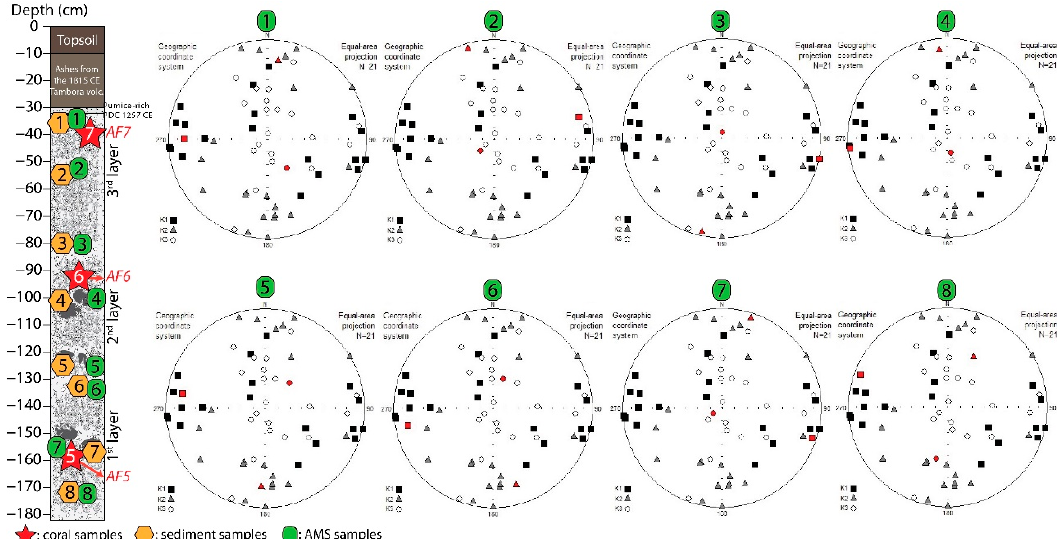
Figure 9. AMS data from T4 which confirm that the fine sandy sediments were emplaced during a calm episode that favors settling in a non-turbulent context in abandoned fishponds in Kiantar Village.